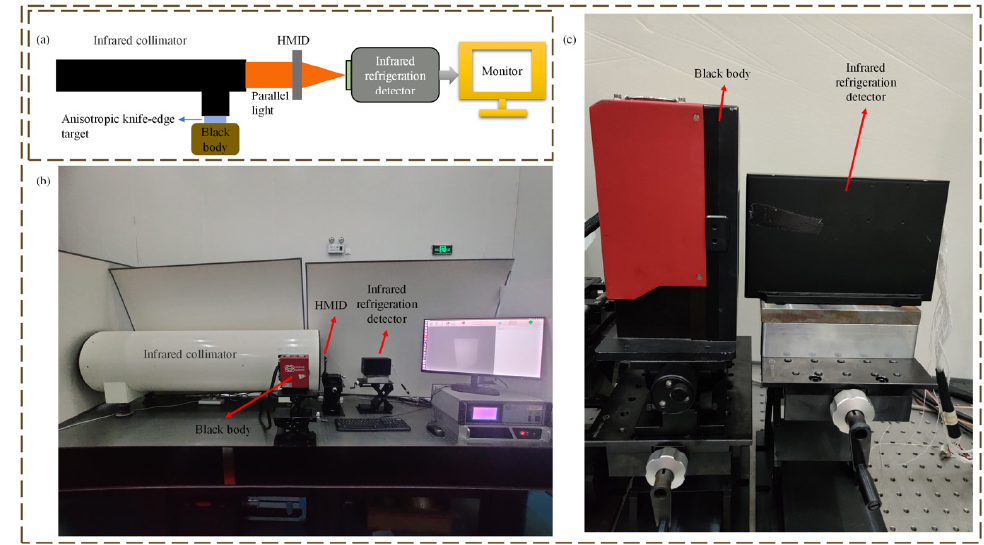
Figure 9. ( a ) Schematic diagram of the optical system used to measure the NETD p arameters of HMID; ( b ) Actual optical system diagram for NETD parameter measurement of HMID; ( c ) Actual optical system diagram for measuring the detector’s NETD.